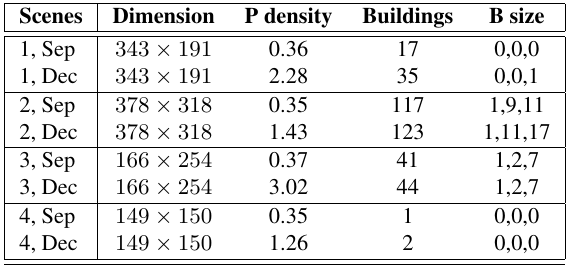
Table 1: Four test data sets, each from two dates: dimensions in metres, point density in points/m 2 , B size indicates the number of buildings within 10 m 2 , 25 m 2 and 50 m 2 in area, respectively.